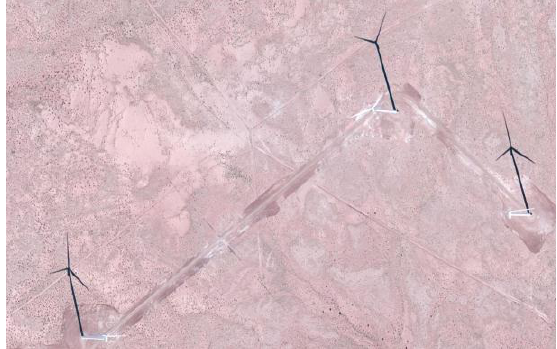
Figure 8. High resolution DTMOrtho, generated automatically by